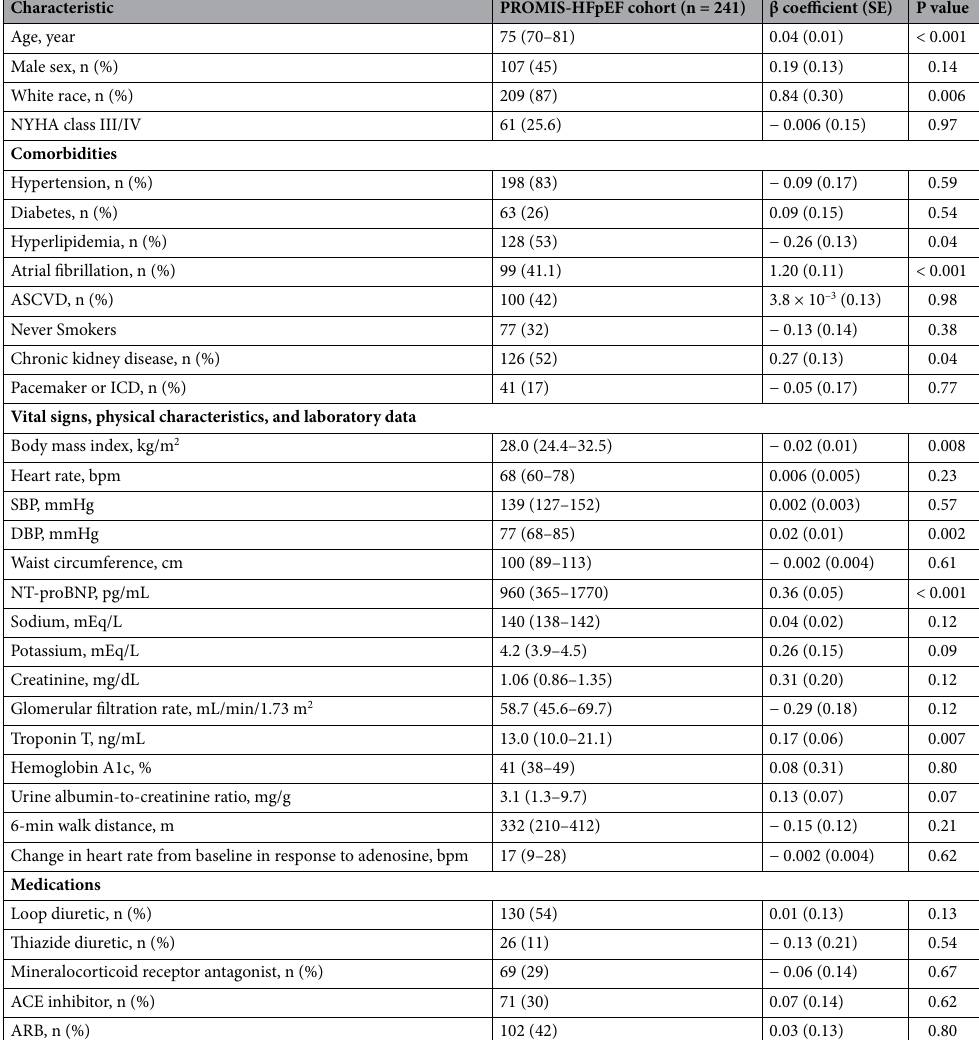
Table 1. Characteristics associated with disproportionate left atrial myopathy in PROMIS-HFpEF. Continuous variables are reported as median (interquartile range). ACE angiotensin converting enzyme, ARB angiotensin receptor blocker, ASCVD atherosclerotic vascular disease, DBP diastolic blood pressure, GFR glomerular filtrate rate; ICD implantable cardioverter-defibrillator, NT-proBNP N-terminal pro-B-type natriuretic